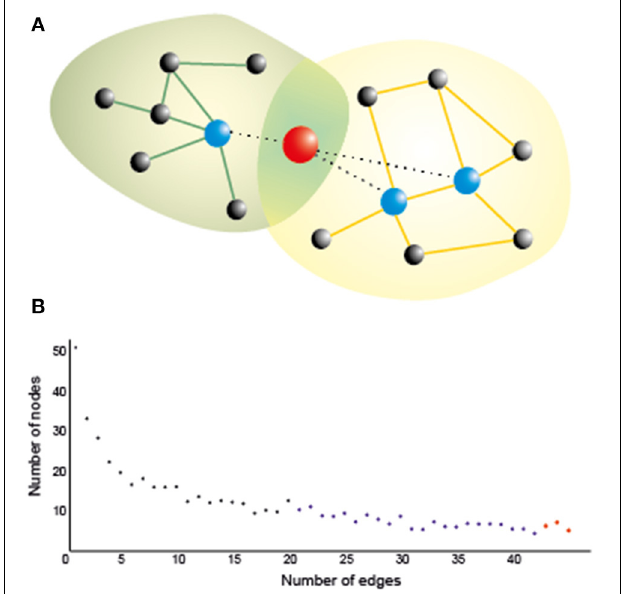
important role in brain functioning. Stimulating a hub is likely to affect many nodesevenatalongdistance,whichcouldmaximizetheeffectofstimulation. Yetnetworksarealsovulnerableagainstadirectedattackonthehubs,sothat their inhibition, however partial and/or transient, may crucially affect the corresponding cognitive functions if it is not properly controlled (e.g., by multisite stimulation of nearby nodes). Green and orange lines : intra-network edges. Dotted lines : edges connecting the hub with nodes in both networks; (B) A typical degree distribution for brain nodes as assessed by a functional connectivity index. Most of the nodes (black) have low degree (i.e., are connected only to a few nodes); some of them (blue) have moderate degree, and a few of them (in red) are hubs, which are connected to many